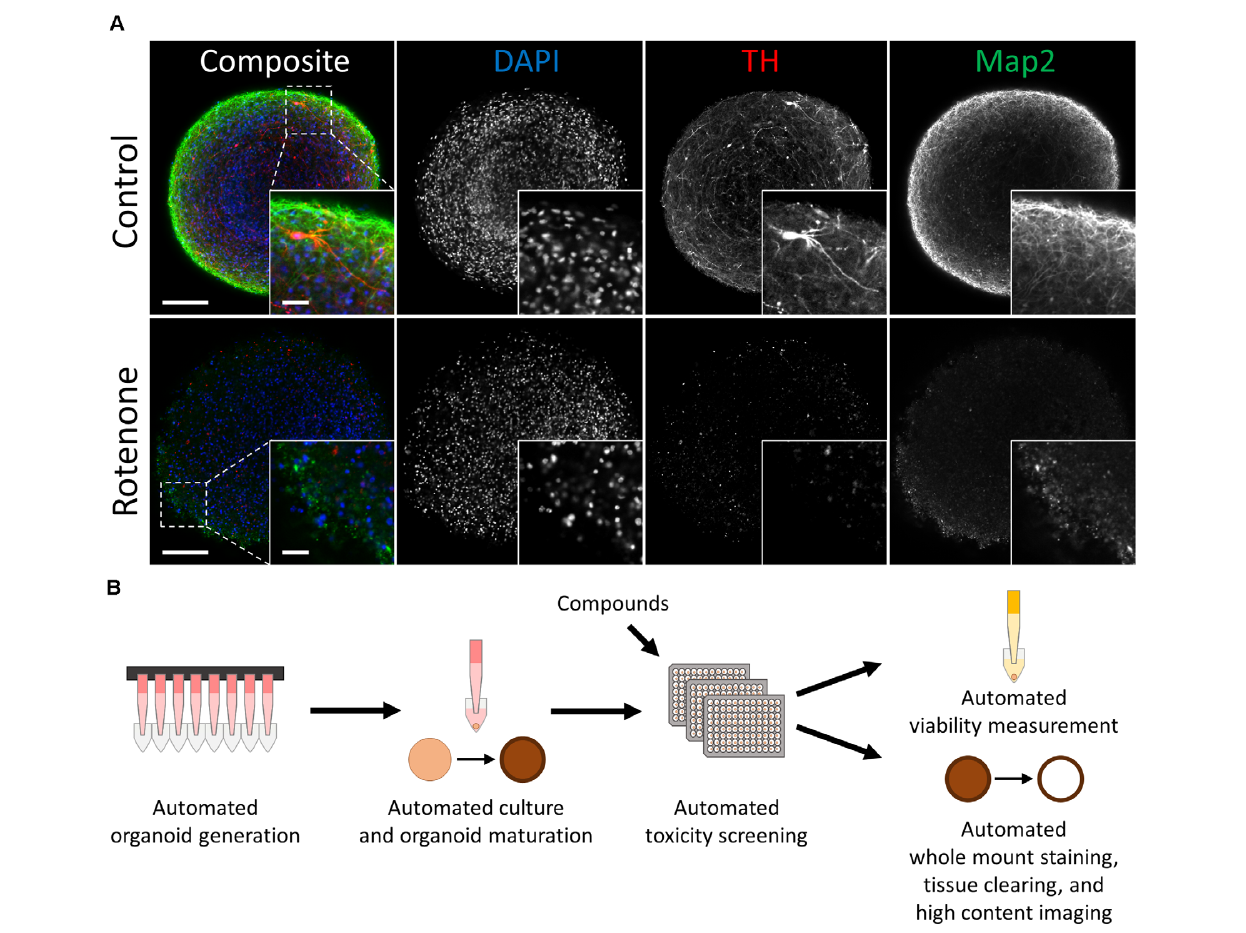
FIGURE 1 | Automated midbrain organoids enable toxicity screening in human tissue-like aggregates. (A) Tyrosine hydroxylase (TH) and MAP2 expression declined with exposure to the toxic compound rotenone (bottom) in comparison to control AMOs of the same age (top, both at day 56 of differentiation). The AMO on the bottom was treated with 100 µ M rotenone for 48 h starting on day 48 of differentiation and afterward kept under standard culture conditions for six additional days before fixation and whole-mount staining (see “Materials and Methods” section for more details). Representative scanning confocal images of a single optical slice of whole-mount stained and cleared AMOs labeled for the general neuron marker Map2 (green) and dopaminergic neuron marker TH (red). Nuclei were counterstained with DAPI (blue). The inlays in the bottom right corner of each image display enlargements of the sections marked by the dotted squares in the respective composite images. Scale bar = 100 µ m (entire AMO), 20 µ m (inlays). (B) Schematic overview of the high throughput screening workflow for the evaluation of overall and cell type-specific